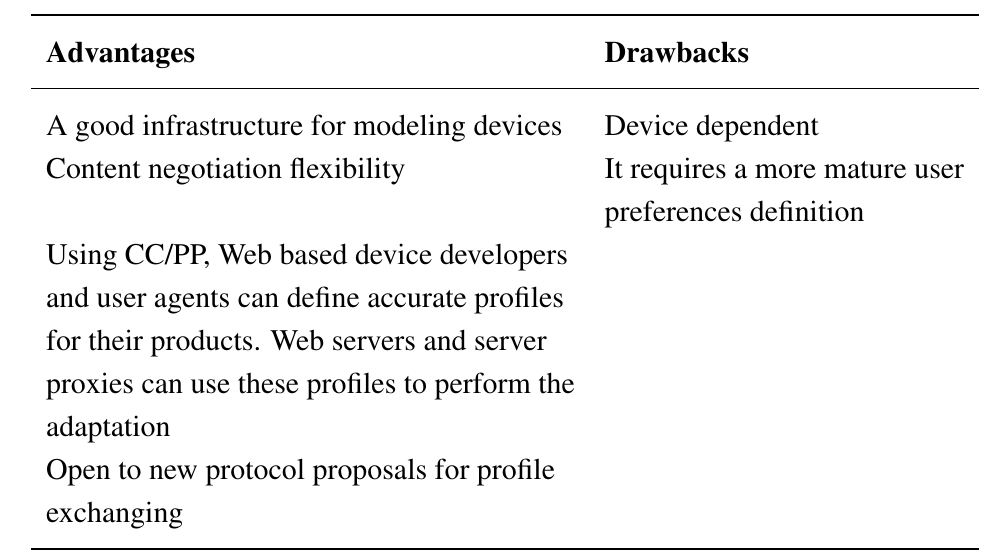
Table 3. CC/PP: several advantages and